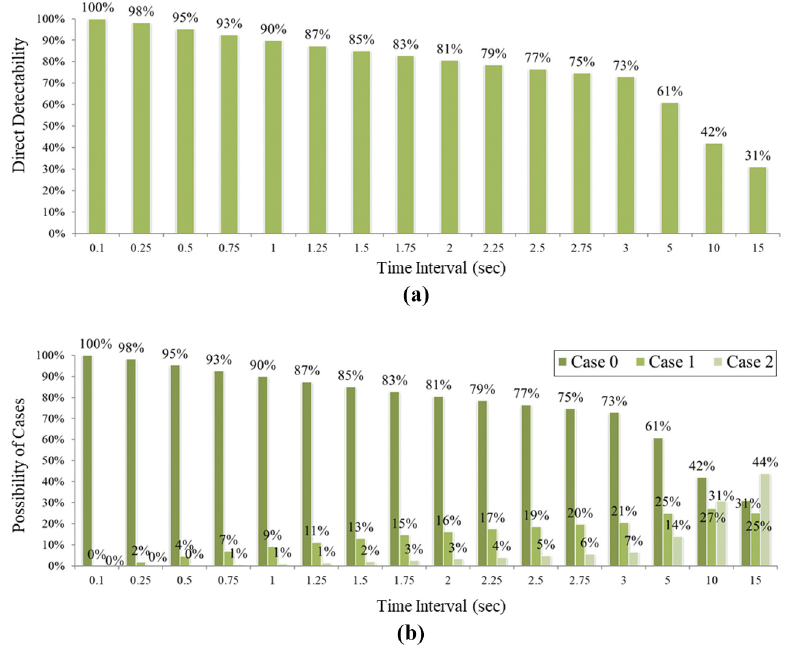
Figure 5 “ Direct detectability ” for data sampled between different time